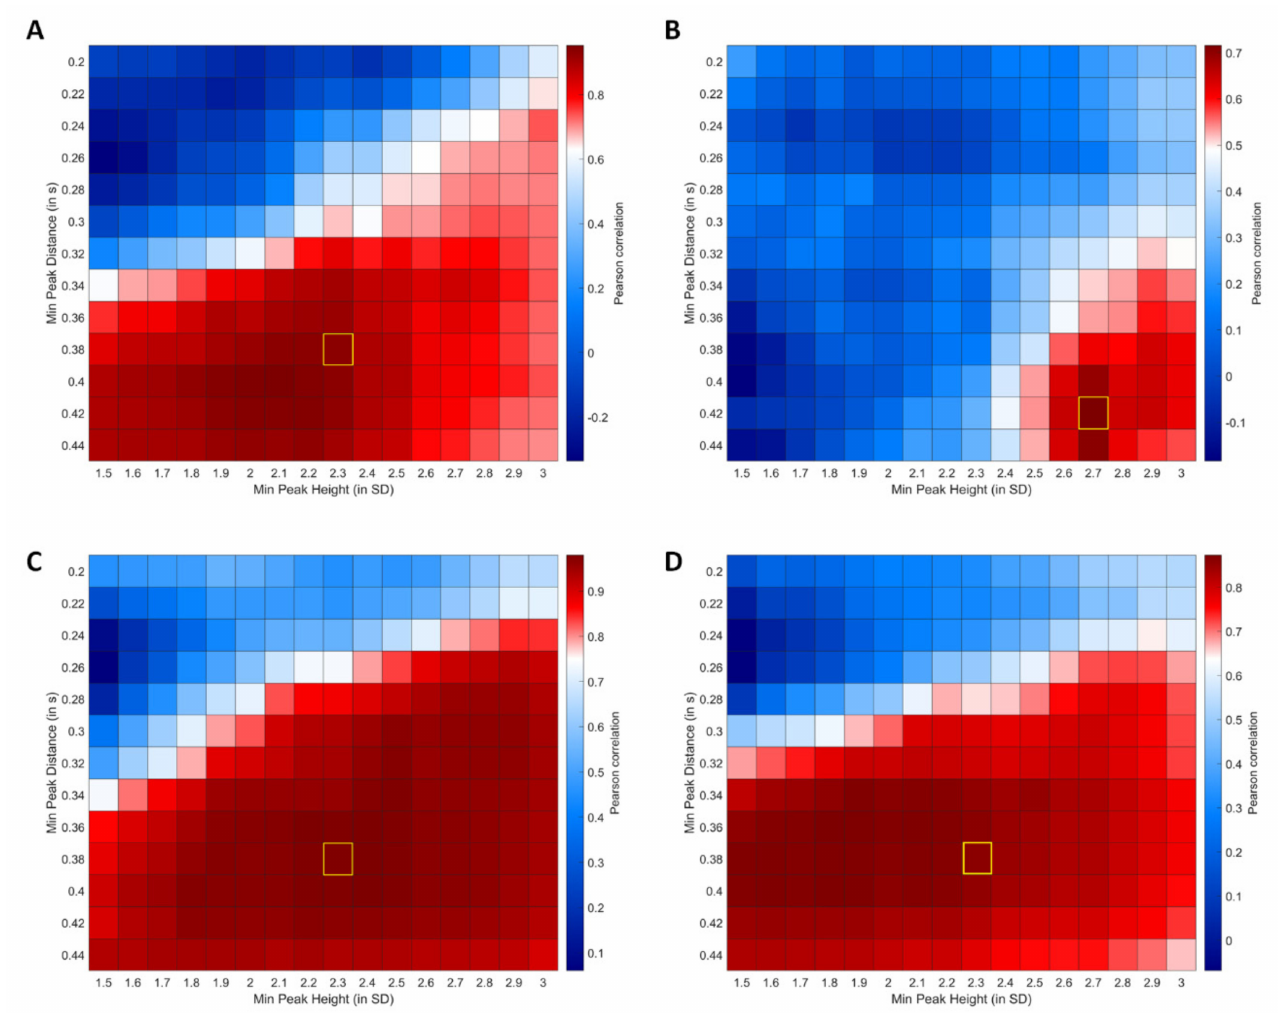
Figure A1. Results of MSI correlation analyses for smartphone step detection parameter optimization. ( A ) Correlation matrix between MSI for backward gait derived from force plate and smartphone data. ( B ) Correlation matrix between MSI for tandem gait derived from force plate and smartphone data. ( C ) Correlation matrix between MSI for normal gait derived using force plate and smartphone data. ( D ) Correlation matrix between MSI for normal gait derived from manual labeling and the automated step detection using smartphone data. Yellow box highlights the final parameters used for subsequent cross-platform